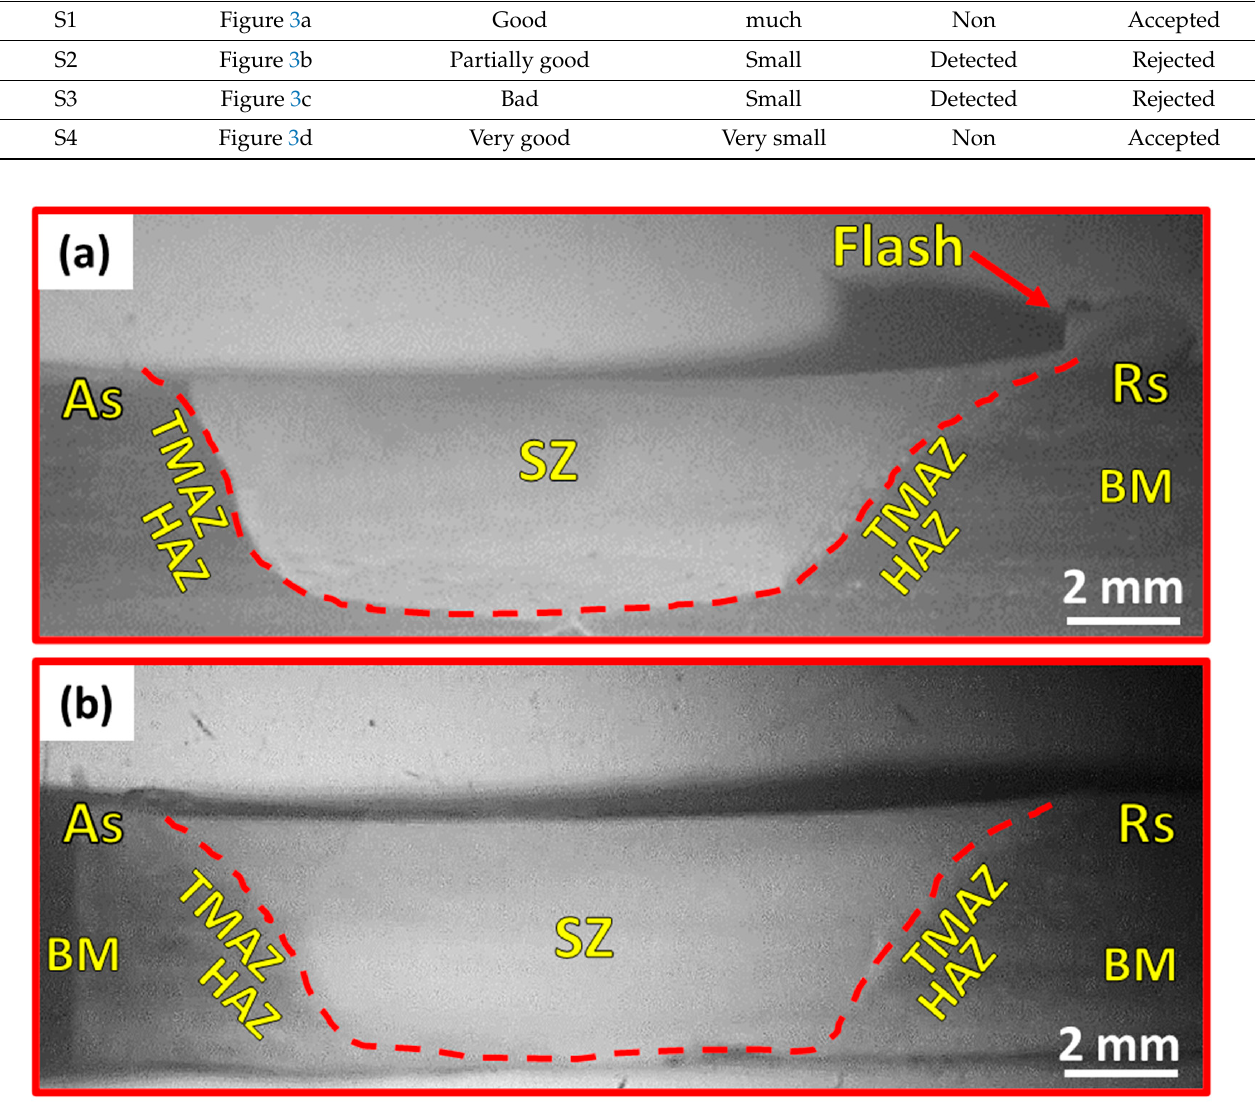
Figure 4. Macrostructures of transverse cross-sections of 2205 DSS butt joints FSWed at ( a ) 600 rpm, 50 mm/min, and 14 kN, and ( b ) 300 rpm, 25 mm/min, and 20 KN.